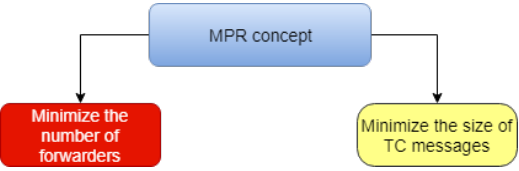
Figure 2. MPR concept of Optimized Link State Routing protocol.